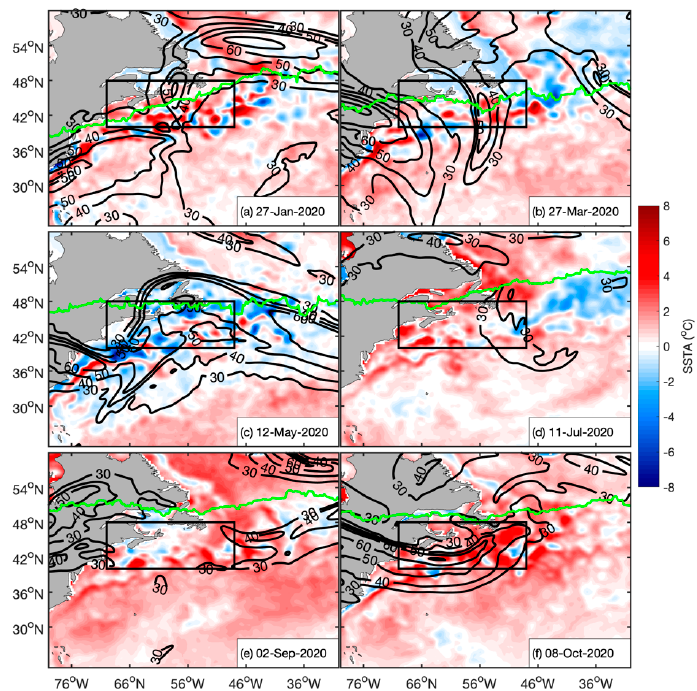
Figure 4. Spatial map of SSTA (°C) in the NW Atlantic throughout 2020. Black contour lines indicate wind speeds (m/s) at 300 hPa and the location of the Jet Stream. Green lines show the mean Jet Stream position based on the daily wind speed at 300 hPa from 1981–2020. Time series data was averaged over 40–48°N and 70–48°W indicated by the box.